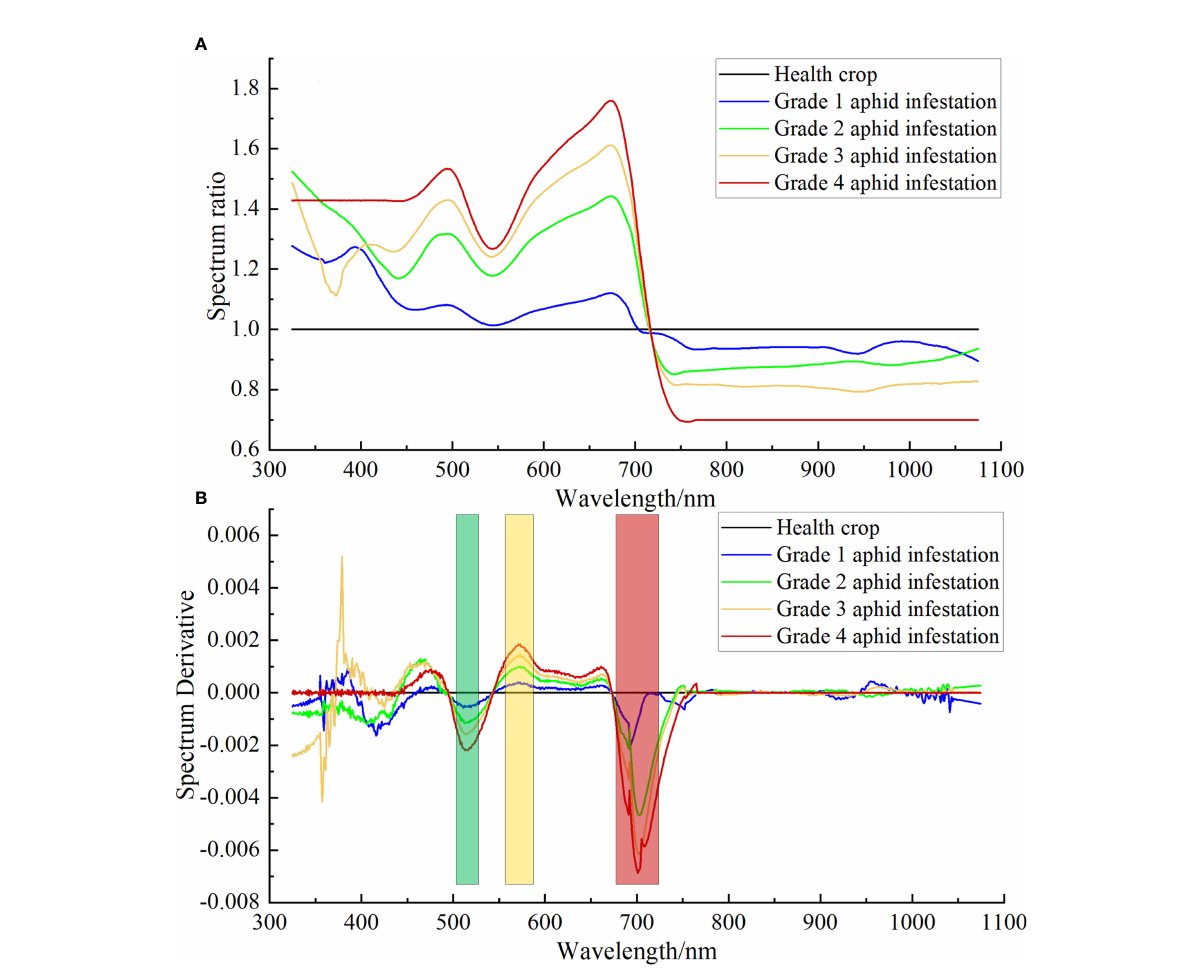
FIGURE 6 DRS results of ASD hyperspectral of cotton aphid infestation at different grades. (A) Ratio spectra of cotton plants infested by different grades of aphids to healthy plants. (B) DRS of cotton plants infested by different grades of aphids to healthy